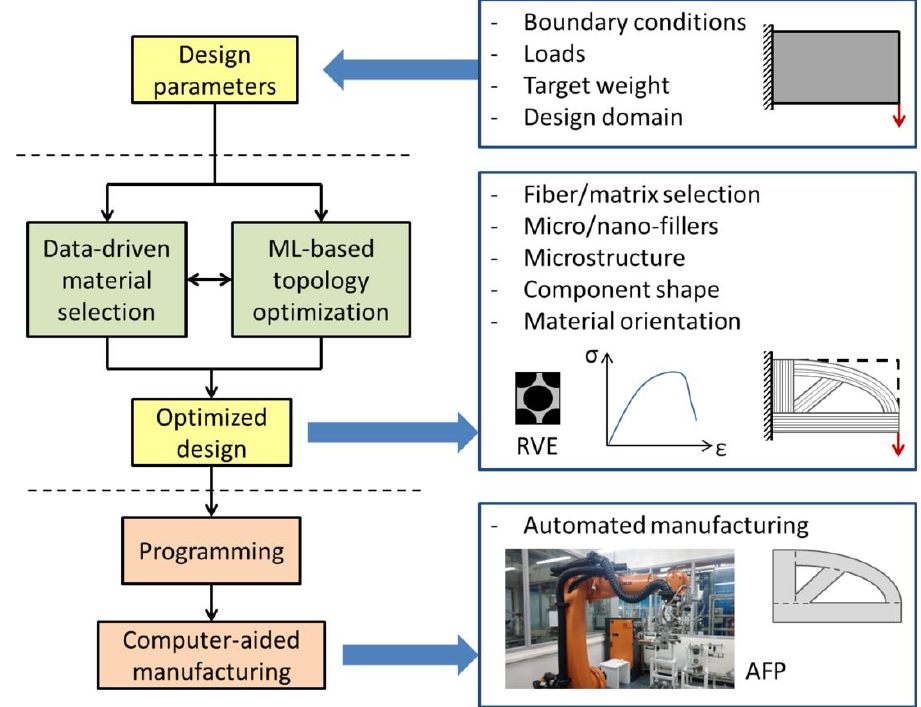
Figure 10. Application of the proposed automated design framework